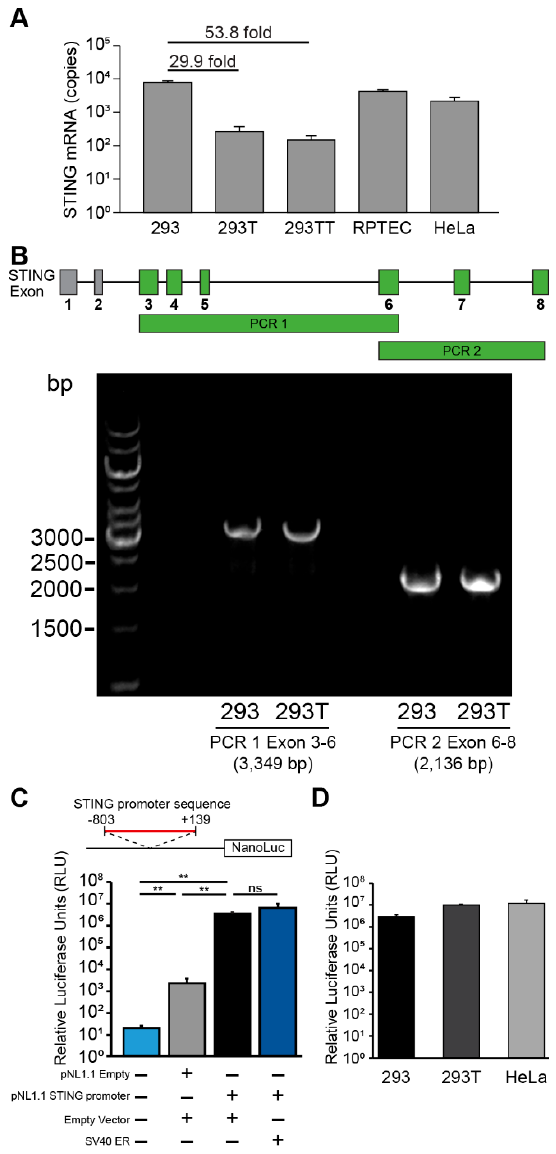
Figure 3. STING transcription is repressed in 293T cells but not in parental 293 cells. ( A ) Quantitative reverse transcription PCR (qRT-PCR) analysis of STING mRNA from the indicated human cell lines is shown. STING mRNA copy numbers were normalized to copies of GAPDH. Absolute copy numbers were determined using validated standard curves. ( B ) The diagram shows the STING coding region and exons 3–8 that encode for the canonical STING protein are highlighted in green. PCR amplification of the STING exons 3–6 (PCR 1, 3349 bp) and exons 6–8 (PCR2, 2136 bp) are indicated. PCR was performed on genomic DNA extracted from 293 and 293T cells. PCR products were separated by electrophoresis on a 0.8% agarose gel. Gel image is representative of three independent experiments. PCR products were cloned into a TOPO vector and Sanger sequenced. ( C ) Luciferase activity of STING promoter-driven luciferase reporter plasmid (90 ng) or the promoterless luciferase control plasmid (100 ng pNL1.1) co-transfected in 293 cells with 100 ng empty LPCX vector or SV40 ER plasmid. The diagram shows the STING promoter sequence cloned upstream of the NanoLuc reporter (Student’s t -test; **, P < 0.01; ns, not significant). NanoLuc luciferase activity was normalized to control TK firefly luciferase activity (TK promoter pGL4.54[luc2 / TK] 10 ng). ( D ) Luciferase activity of STING promoter-driven luciferase reporter plasmid (90 ng) in indicated cell lines. Error bars indicate standard deviations from three replicates. These data are representative of at least three independent experiments.